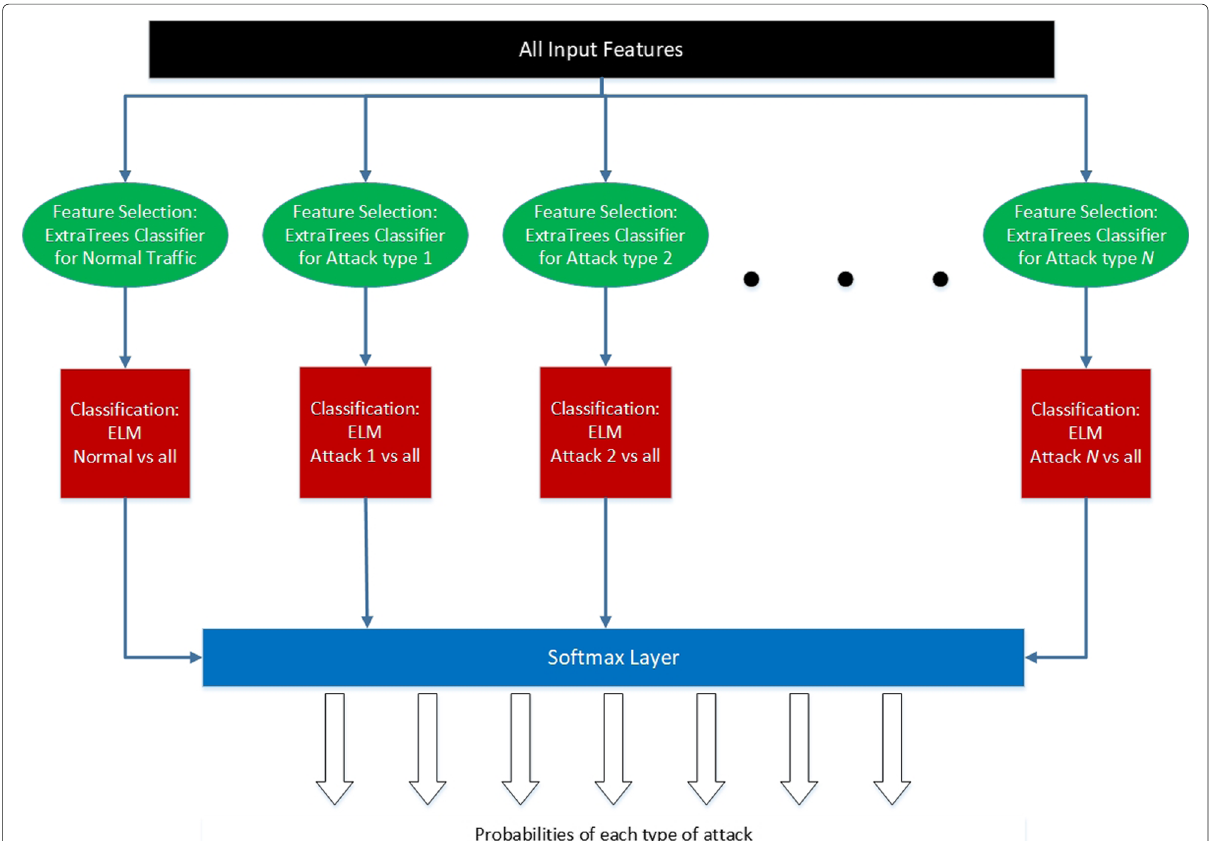
Fig. 1 Multi-layer intrusion detection system